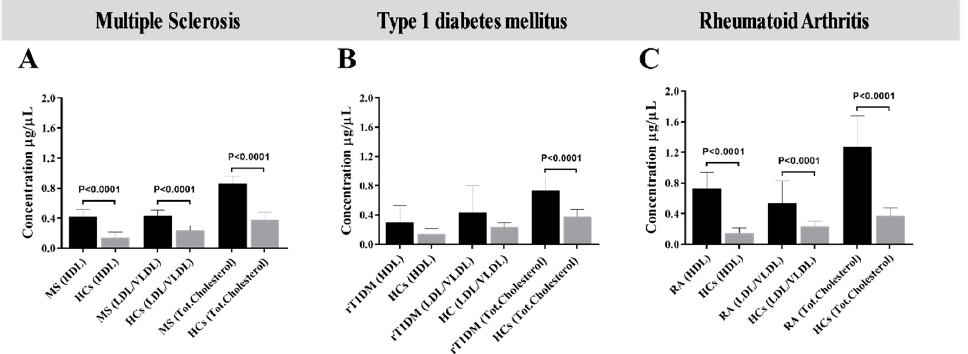
Figure 1. Levels of serum lipoproteins determined through disease-specific analysis. Bars show values were determined in samples from patients ( A ) with MS, (B ) at risk of T1DM (rT1DM) and ( C ) affected by RA, each analyzed with reference to concentrations obtained for healthy controls (HCs). p-values are specified for each group when statistically significant. Standard deviation is shown for each bar.